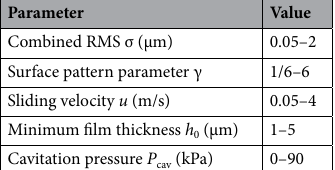
Table 6. Input parameters for the